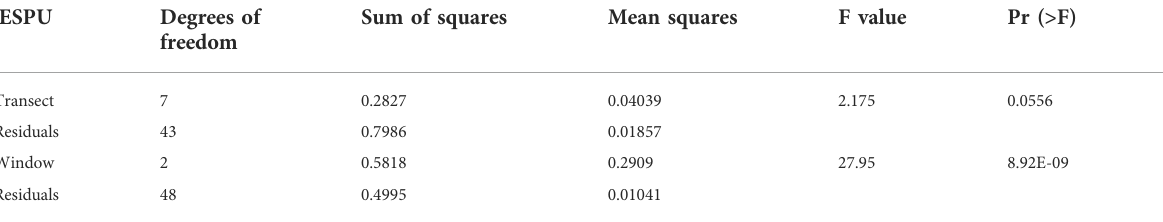
TABLE 2 ANOVA for ESPU of the nutrient availability indicator. α = 0.05. Orotoy river basin. Source: Elaborated by the authors.